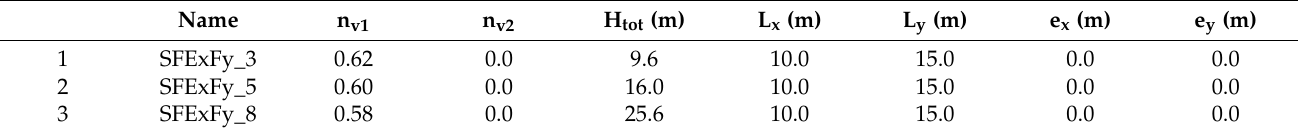
Table 9. Structural data of the three examined buildings with unknown data used for the prediction of their DS.